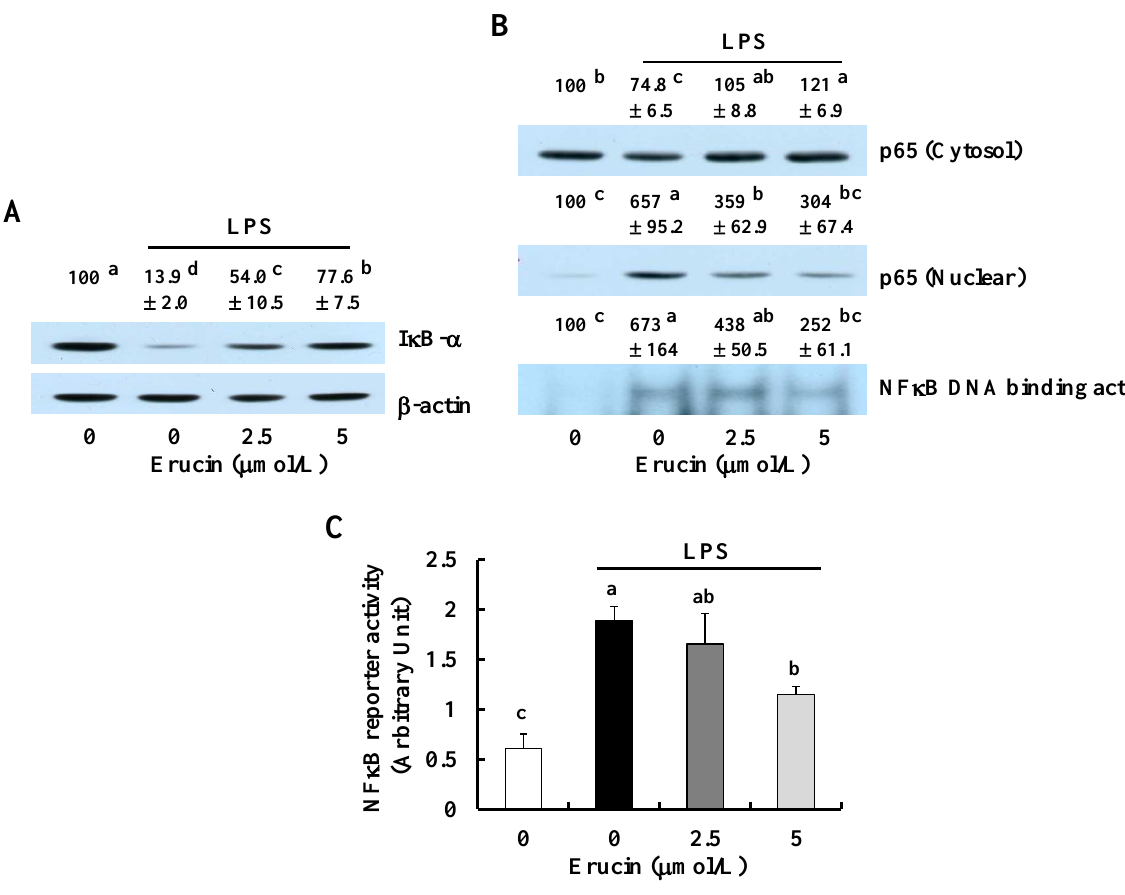
Figure 4. Erucin inhibits LPS-induced activation of NFκB signaling in RAW 264.7 cells. ( A , B ) RAW 264.7 cells were treated with various concentrations of erucin for 30 min. LPS was then added and incubated for another 20 min. ( A ) Total cell lysates were subjected to Western blotting with their relevant antibodies; ( B ) Cytosolic fractions and nuclear extracts were prepared for Western blotting with an anti-p65 antibody and Electrophoretic Mobility Shift Assay (EMSA). The relative abundance of each band was quantified, and the control levels were set at 100%. The adjusted mean ± SEM ( n = 3) of each band is shown above each blot; ( C ) RAW 264.7 cells were transfected with NFκB-luciferase reporter plasmid. The transfected cells were treated with various concentrations of erucin in the presence of LPS. Cell lysates were prepared to determine luciferase activity. Each bar represents the mean ± SEM ( n = 4). Means without a common letter differ ( p <